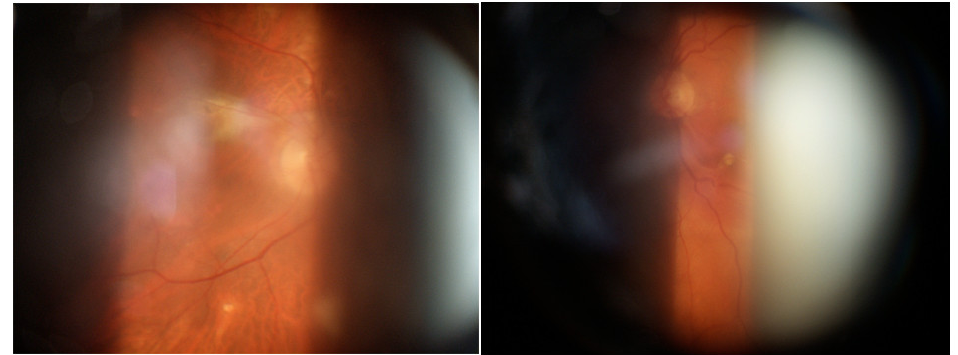
Figure 16. Bilateral chorio-retinal involvement in a patient with OS.